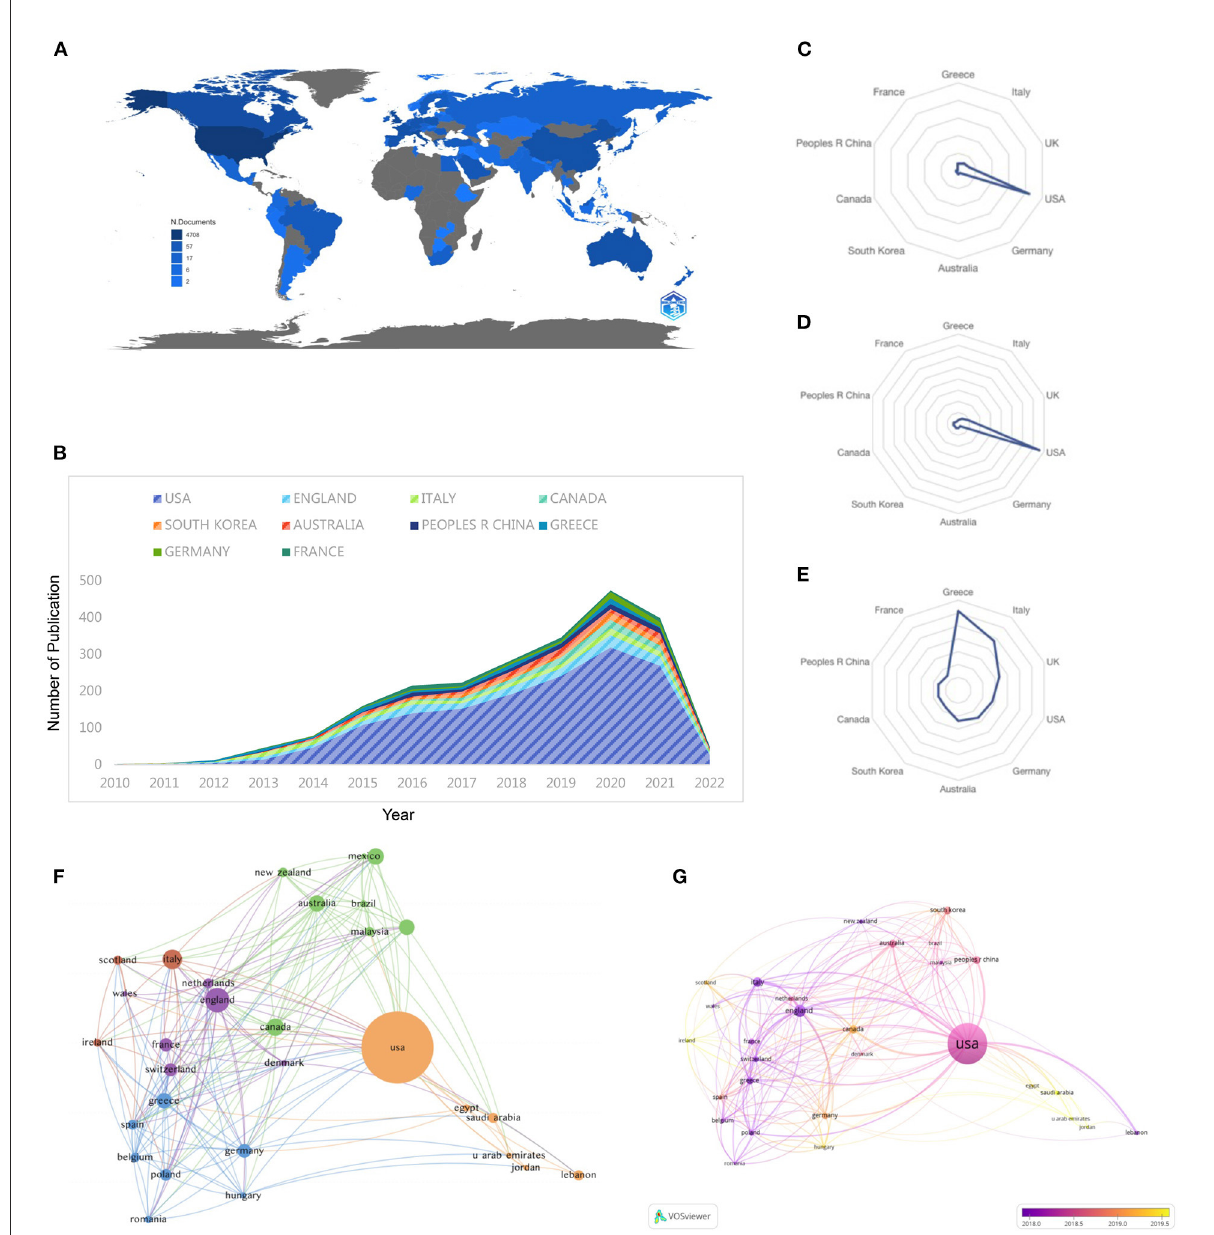
FIGURE2 Country analysis of published e-cigarette research literature. (A) country analysis of published literature worldwide; (B) trends in the number of publications in the top 10 publishing countries over the years; (C) radar plot of total literature in the top 10 publishing countries; (D) radar plot of TGCS in the top 10 publishing countries; (E) radar plot of average citations in the top 10 publishing countries; (F) visual cluster analysis of collaboration among publishing countries; (G) time of cooperation in each country visualization analysis